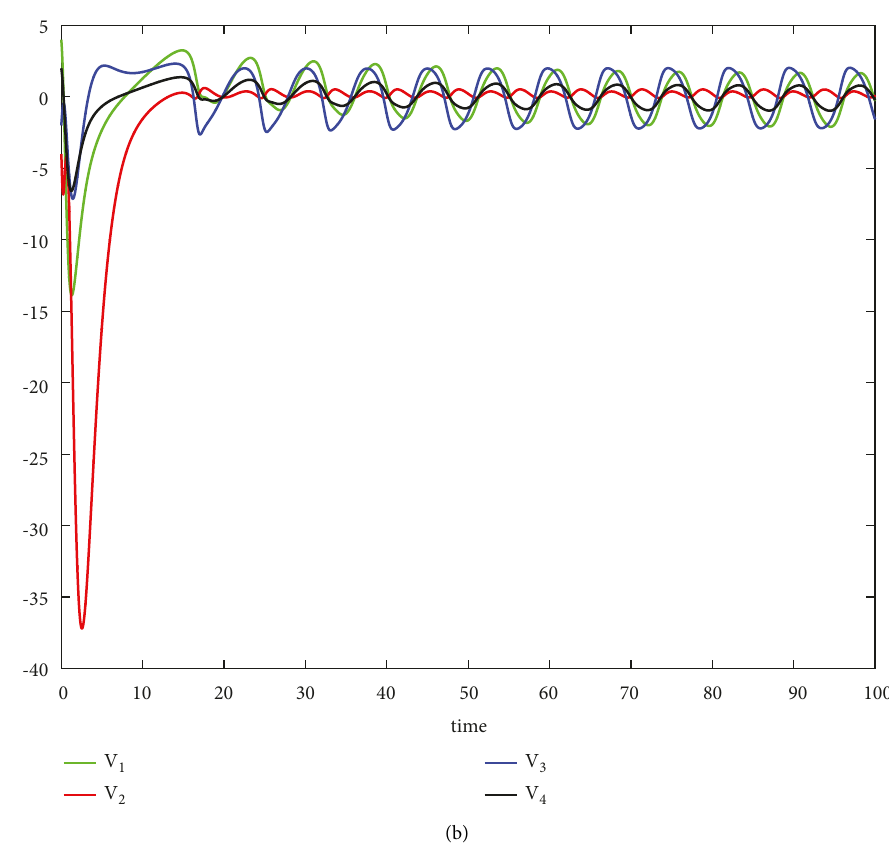
Figure 9: Antisynchronization of identical 4D hyperchaotic financial system: (a) 􏽢 a, 􏽢 b, 􏽢 c, 􏽢 d, and 􏽢 k represent the adaptation of unknown , v ,v , and v represent the time-varying parameters. (b) v 1 2 3 4